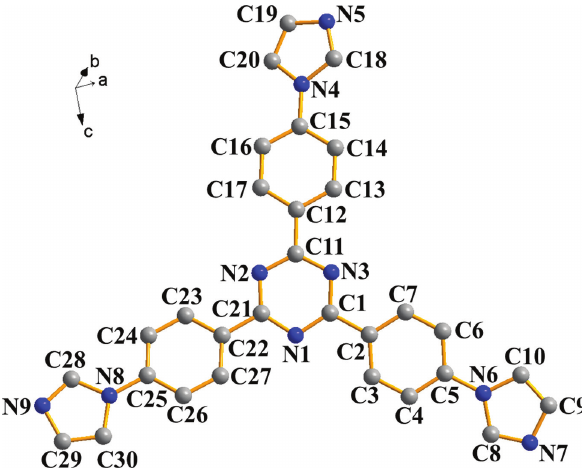
Table 1: Data collection and handling.